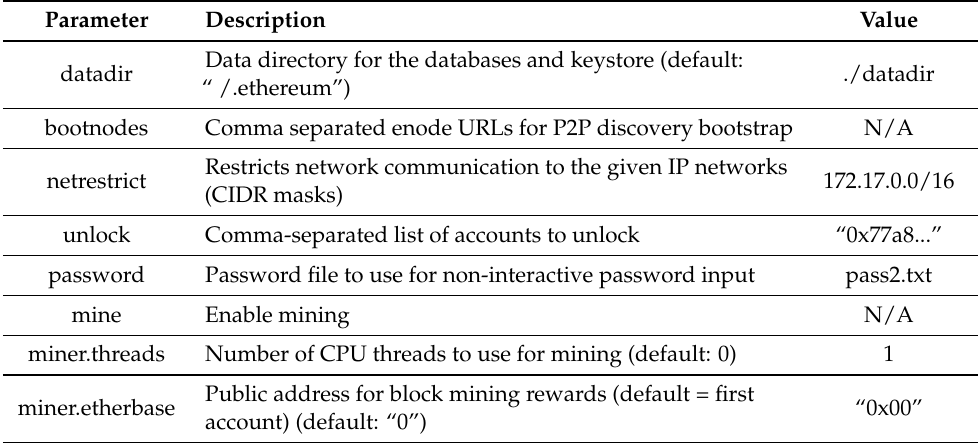
Table 2. Ethereum miner configuration